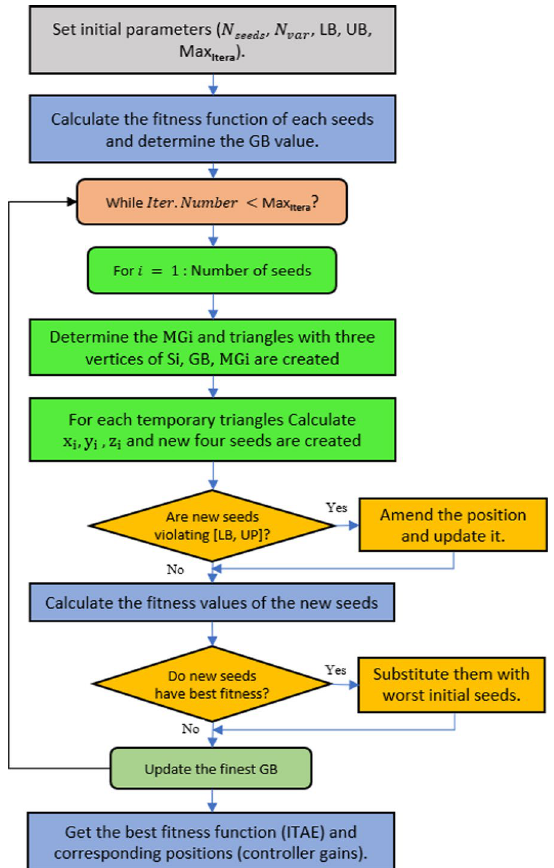
Table 1 Comparison of ITAE values over 20 independent